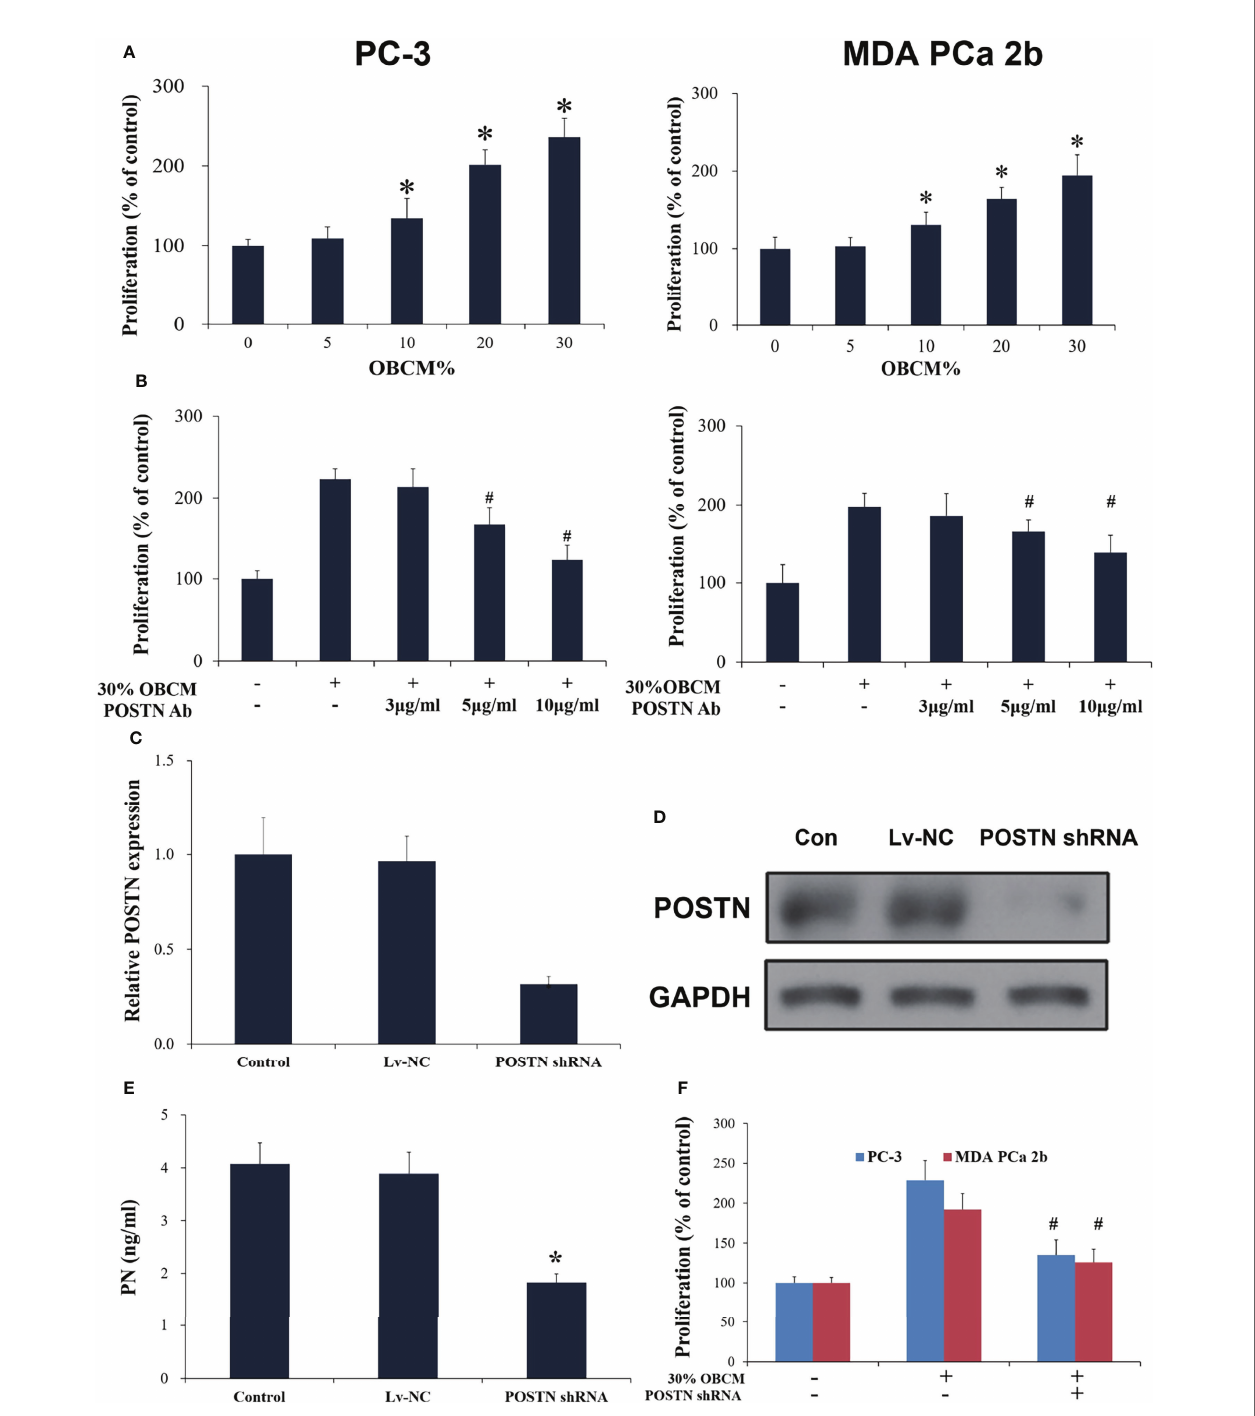
FIGURE 4 | Osteoblast-derived POSTN promoted proliferation of PCa cells. (A) PC-3 and MDA PCa 2b cells were incubated with various concentrations of osteoblast (hFOB)-conditioned medium (OBCM) for 48 h before proliferation was assessed. (B) PC-3 and MDA PCa 2b cells were incubated with 30% OBCM supplemented with various concentrations of POSTN monoclonal antibody for 48 h before proliferation was assessed. (C) hFOB cells were transfected with control shRNA lentivirus (Lv-NC) or POSTN shRNA lentivirus (POSTN shRNA). The expression of POSTN was detected by real-time PCR. (D) hFOB cells were transfected with control shRNA lentivirus (Lv-NC) or POSTN shRNA lentivirus (POSTN shRNA). The expression of POSTN was detected by Western blotting. (E) The levels of POSTN in hFOB cell medium were detected by ELISA. (F) PC-3 and MDA PCa 2b cells were incubated with 30% OBCM from control or POSTN-knockdown hFOB cells. Proliferation was assessed after 48 h. * p < 0.05 compared with control; # p < 0.05 compared with the OBCM-treated